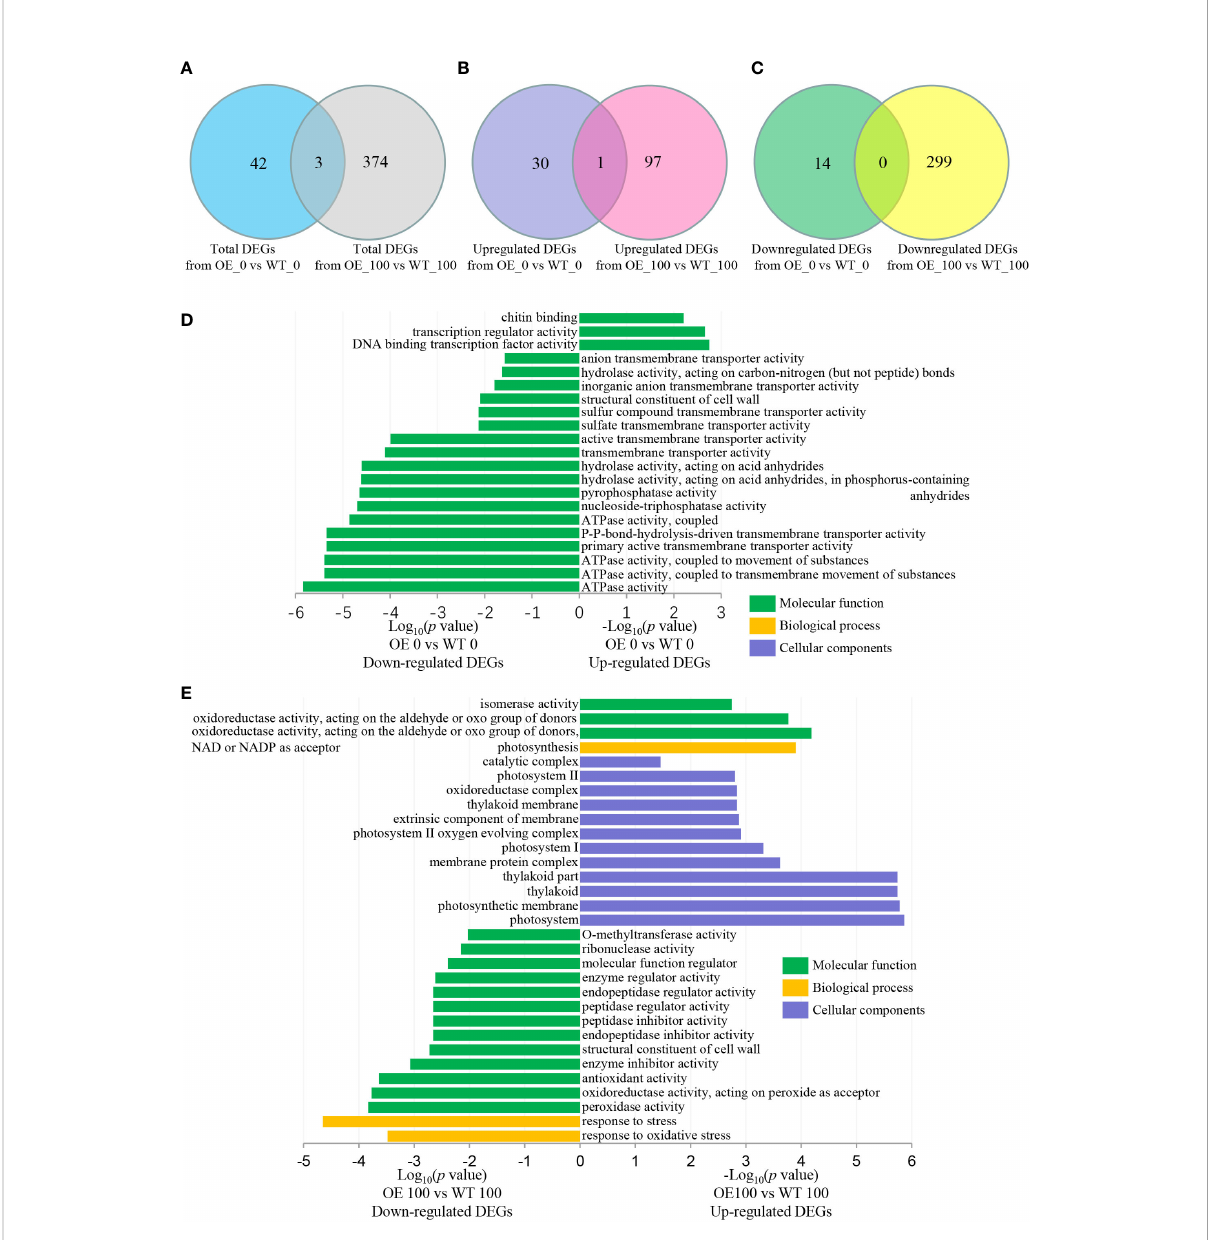
FIGURE 5 NbCIPK25 induces DEGs enriched for different GO terms between normal and salt condition. (A – C) Venn diagram of total (A) , upregulated (B) and downregulated (C) DEGs from NbCIPK25 overexpressing plants vs WT under 0 mM NaCl or 100 mM NaCl treatment. “ 3 ” in panel A means the overlapping DEG number between total DEGs caused by NbCIPK25 overexpression under normal condition and salt condition. “ 1 ” in panel B means the overlapping DEG number between upregulated DEGs caused by NbCIPK25 overexpression under normal condition and salt condition. “ 0 ” in panel C means no overlapping DEG between downregulated DEGs caused by NbCIPK25 overexpression under normal condition and salt condition. (D, E) Functional classi fi cation of upregulated and downregulated DEGs from NbCIPK25 overexpressing plants vs WT under 0 mM NaCl treatment (D) and 100 mM NaCl treatment (E) , respectively, using GO annotations with p < 0.05 as cut-off